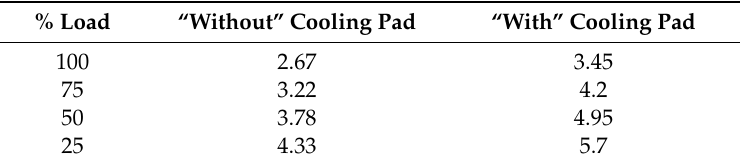
Table 3. Average COP values for each load factor of the chiller